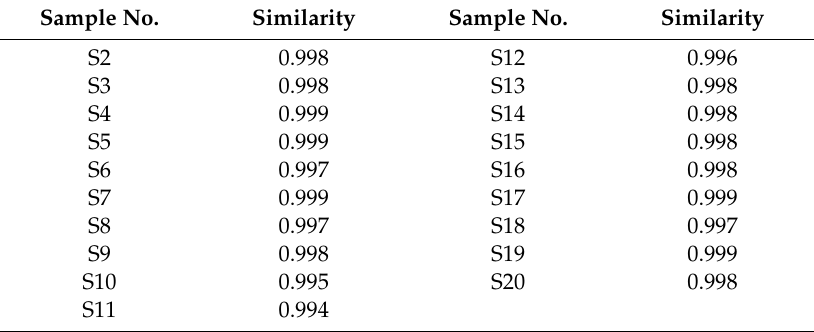
Table 1. Similarity values of tested